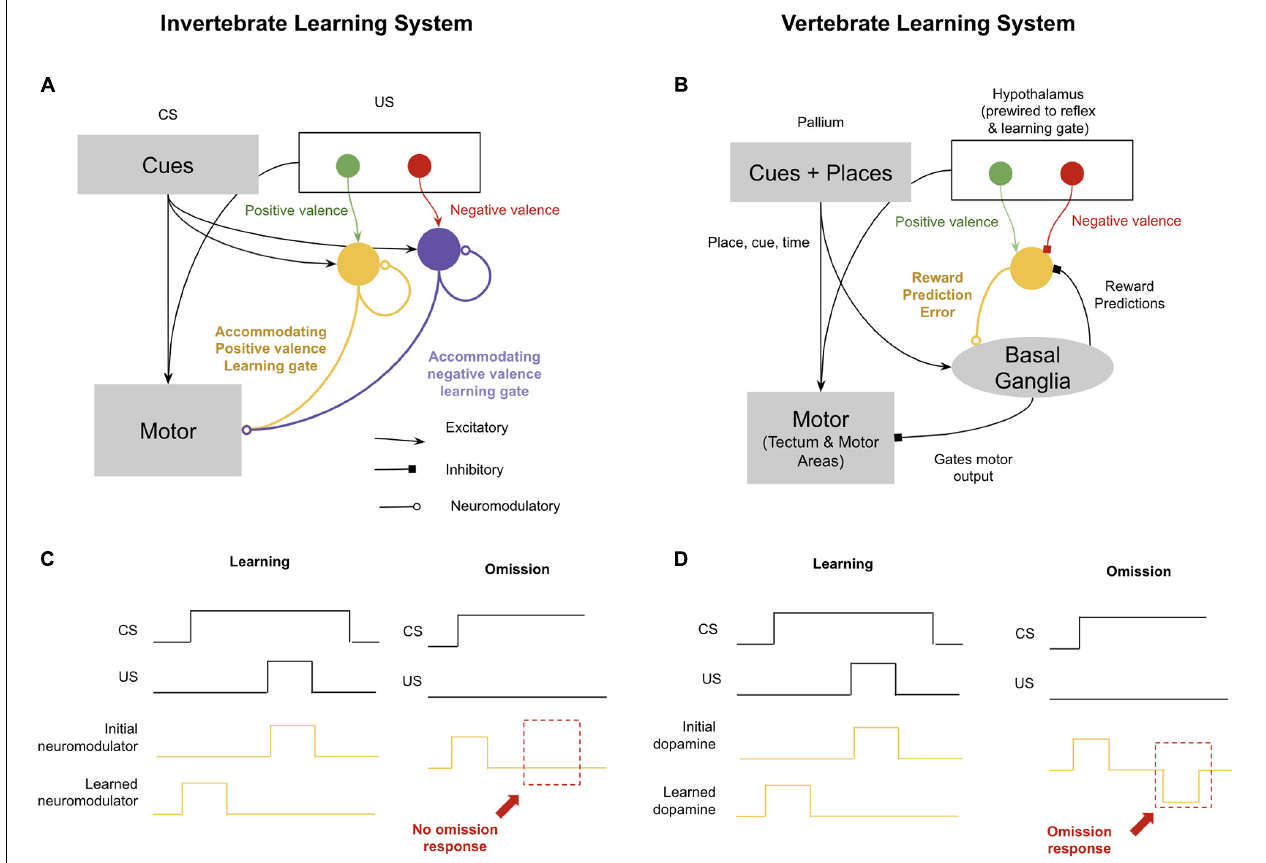
FIGURE 4 | Difference in reinforcement learning between (most) invertebrates and vertebrates. Invertebrates implement reinforcement learning through accommodating neuromodulators, each of which modulates different valences and reflexes. This enables complex learning, but not omission learning. In contrast, vertebrates use dopamine to encode both positive and negative reward prediction errors, which enables learning through omission. See text for details. (A) Schematic of invertebrate reinforcement learning system. (B) Schematic of vertebrate reinforcement learning system. (C) Example of associative learning in accommodating neuromodulator response to conditioned stimulus (CS) predictive of unconditioned stimulus (US). Omission example (right) demonstrates lack of inverse response to omitted US. (D) Example of associative learning in dopamine reward prediction error. Omission example (right) demonstrates presence of omission response when US is omitted (after